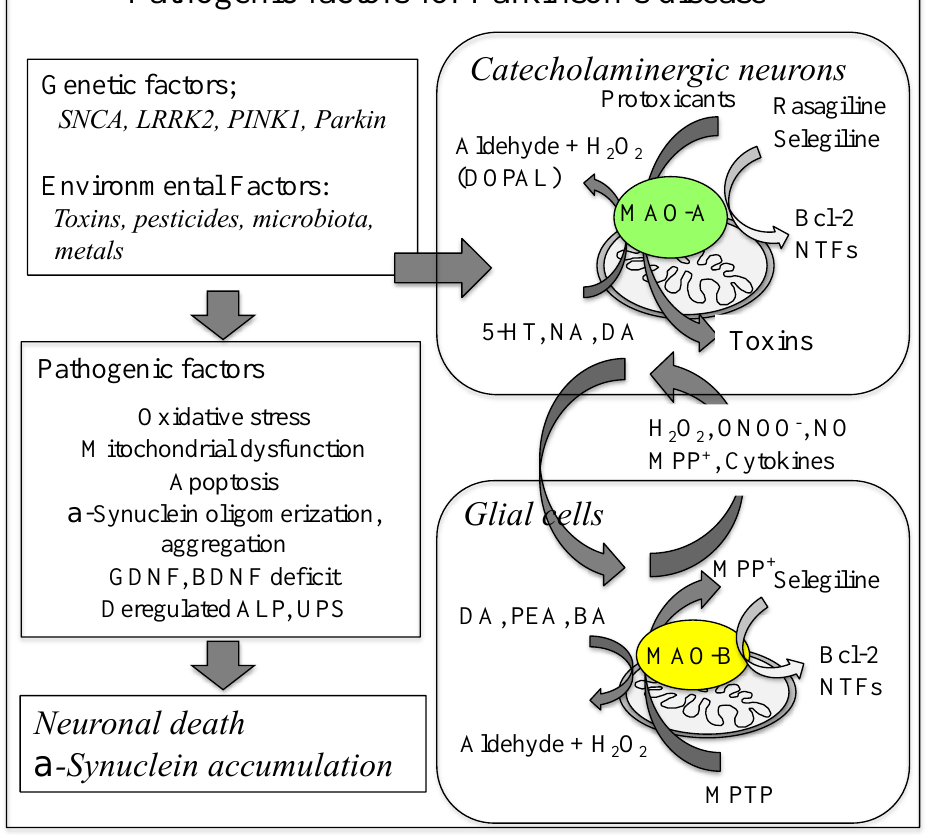
Figure 1. Role of MAO-A and MAO-B in the pathogenesis of PD. MAO-A in catecholaminergic neurons and MAO-B in glial cells produce ROS and neurotoxins, and induce death of DA neurons, neuroinflammation and α Syn accumulation. MAO-A mediates toxicity of endogenous dopaminergic neurotoxin, N -methyl( R )salsolinol, and gene-induction by rasagiline in dopaminergic cells. MAO-B oxidizes monoamines, produces ROS and MPP + from MPTP, and mediates gene induction by selegiline in glial cells. ALP, autophagy-lysosome pathway; UPS, ubiquitin-proteasome system. MAO-B oxidizes DA, increases oxidative stress, produces neurotoxins from protox- icants, causes astrogliosis, and induces neuronal loss of the parkinsonian brain. Single- nucleotide polymorphism (SNPs) A644G (rs1799836) in the intron 13 of mao-b is known to